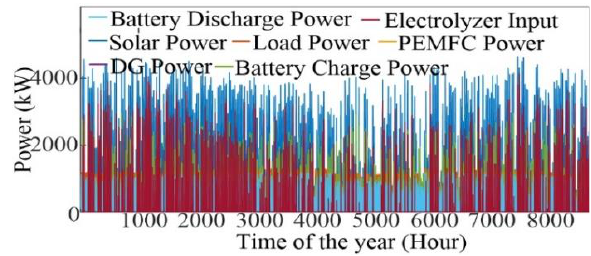
Figure 15. Power generation and consumption over the year: combination 4.